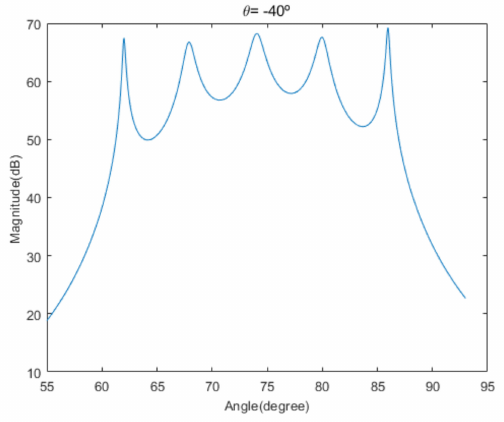
Figure 12. Spatial spectrum of Beamspace MUSIC in the proposed algorithm, for the third scenario (elevation angle = − 40 ◦ ).